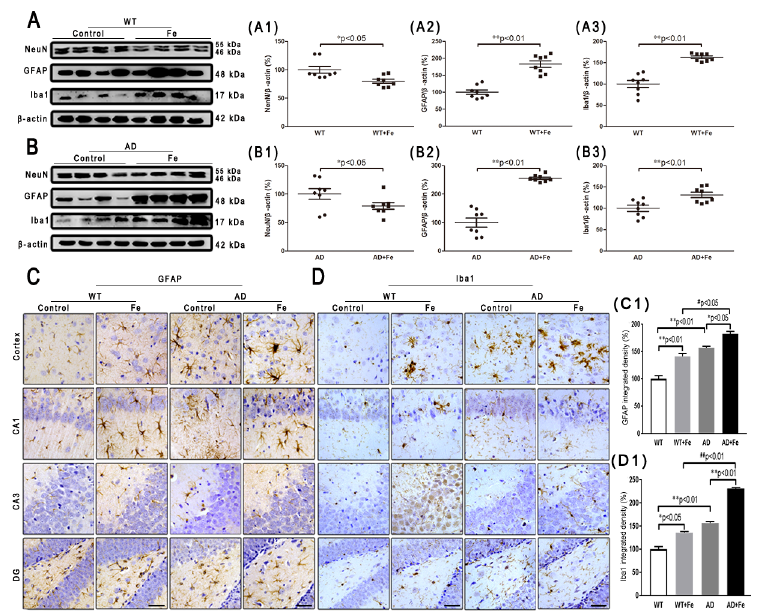
Figure 3. Effect of HDI on neurons and glia. ( A , B ) Western blot analysis of NeuN, glial fibrillary acidic protein (GFAP) and ionized calcium-binding adapter molecule 1 (Iba1). ( A1 – A3 , B1 – B3 ) Quantitative analyses of Western blot for NeuN, GFAP and Iba1. β -actin was used as an internal control. ( C , D ) Immunohistochemistry staining of GFAP and Iba1. ( C1 , D1 ) Quantitative analyses of GFAP-positive astrocytes staining and Iba1-positive microglia staining. Scale bar = 50 µ m. All results are presented as the mean ± SEM ( n = 8). * p < 0.05, ** p < 0.01 compared with the control group; # p < 0.05, # # p < 0.01 compared with the iron-treated WT group.